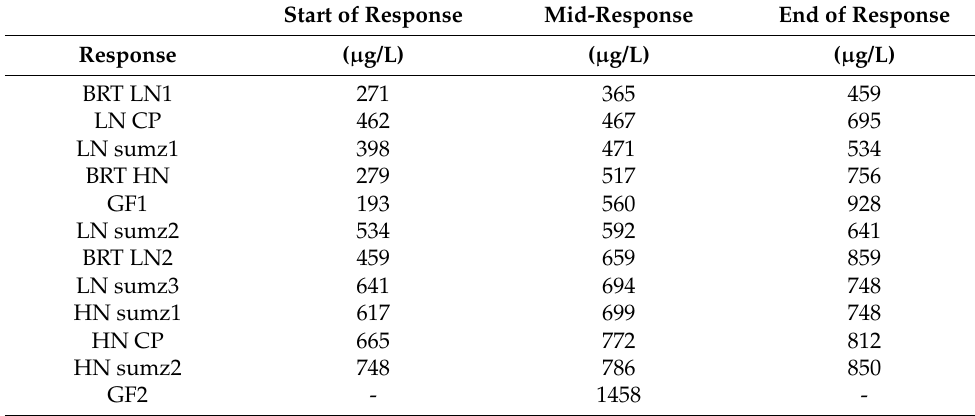
Table 2. Summary of TN responses (Sorted by mid-response). CP is change point (mid-response) for TITAN results with start and end being 5th and 95th percentiles of bootstrapped change points. BRT = boosted regression trees, GF = gradient forest analysis, LN = low nitrogen ASVs, HN = high nitrogen ASVs. The sumZ responses are from TITAN distributions of bootstrapped community change points. GF2 had no discernable start or end of response because it only briefly exceeded the density-of-splits to density-of-data ratio of